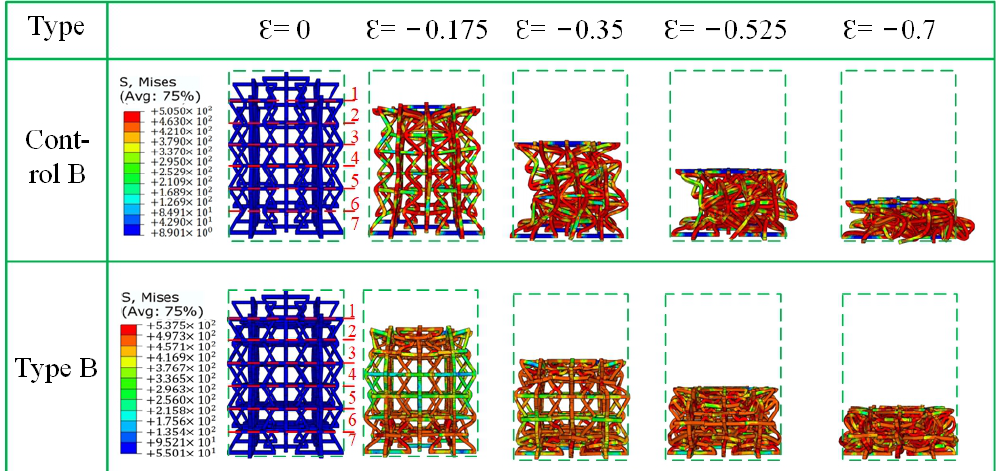
Figure 13. Fragmentation process of type B in the y direction.